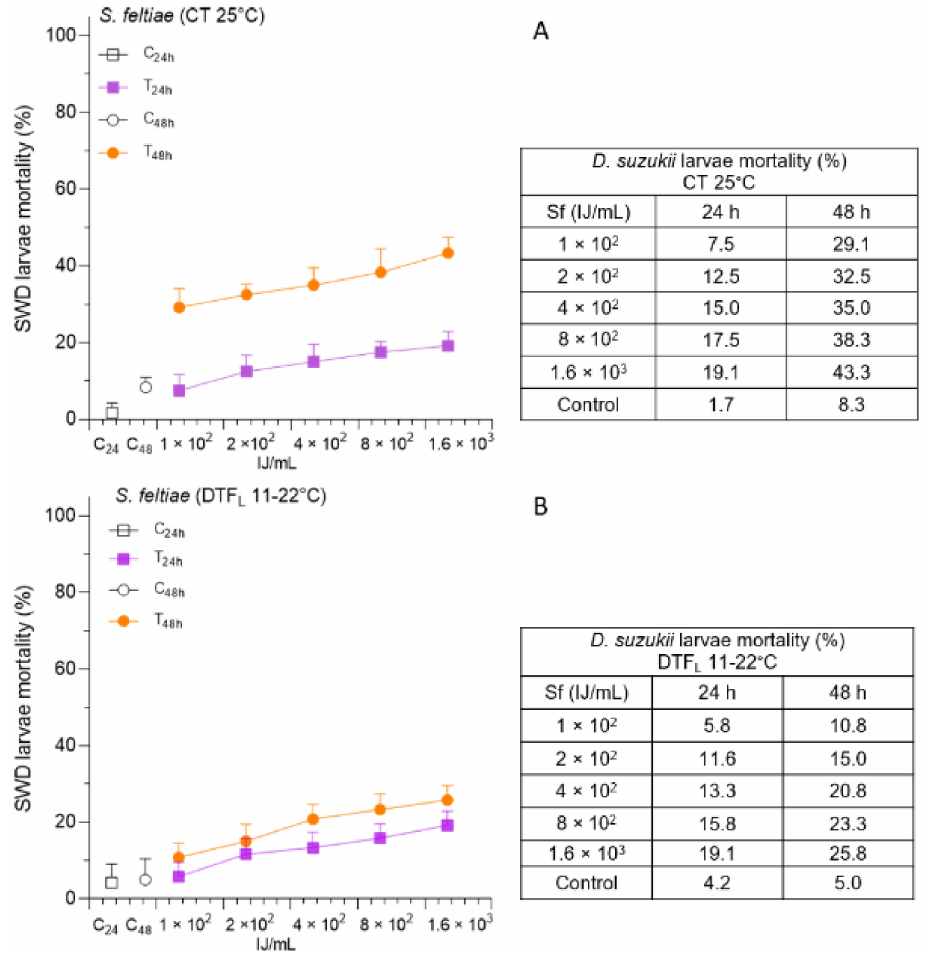
Figure 3. The efficacy of Steinernema feltiae (Sf), at increasing concentrations, was evaluated as percentage mortality of Spotted Wing Drosophila (SWD) larvae (mean plus standard deviation), at 24 and 48 h, under constant temperature—CT 25 ◦ C ( A ), and low-temperature fluctuation—DTF L 11–22 ◦ C ( B ).